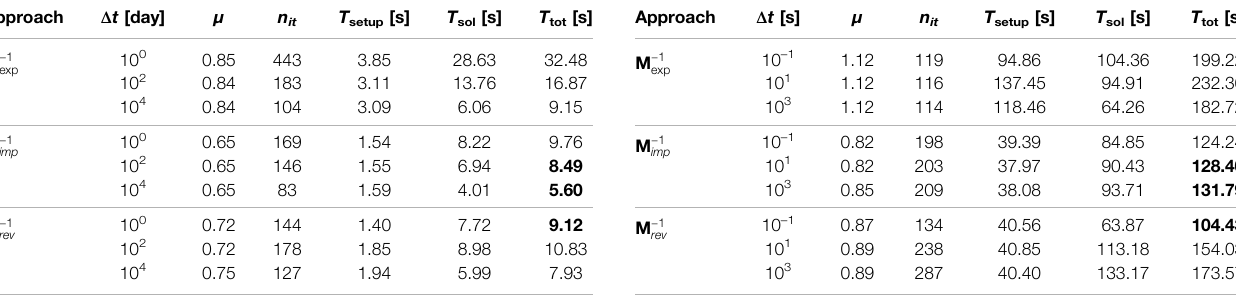
TABLE 2 | Treporti test case: computational performance. Approach